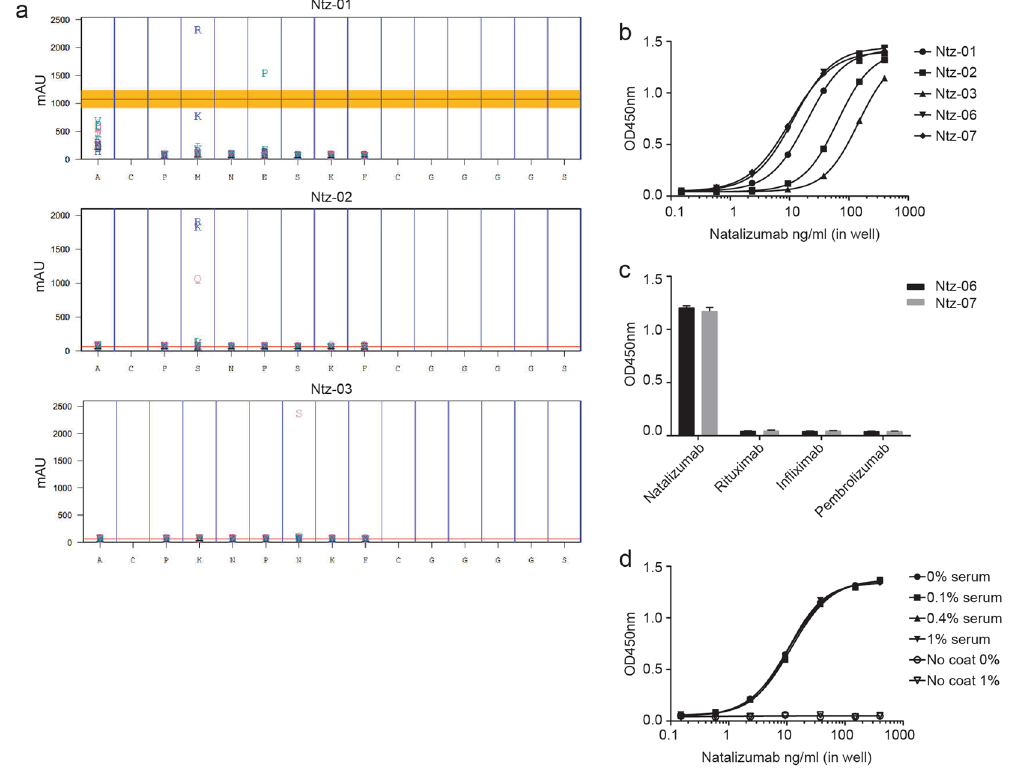
Figure 4. Affinity maturation of selected peptides and performance in ELISA ( a ) Relative binding (arbitrary units) of single amino acid substitution and deletion variations of Ntz-01, Ntz-02, and Ntz-03. Natalizumab binding (y-axis) to each sequence variation is depicted as single-letter amino acid substitutions at each sequence position (x-axis). Deletions are denoted as “ − ” on the graph (all deletions produce binding similar to or worse than baseline). The red lines indicate natalizumab binding to the parent sequence. ( b ) Natalizumab capture by Ntz-06 and Ntz-07 compared with Ntz-01, Ntz-02, and Ntz-03 in ELISA. ( c ) Selectivity of Ntz-06 and Ntz-